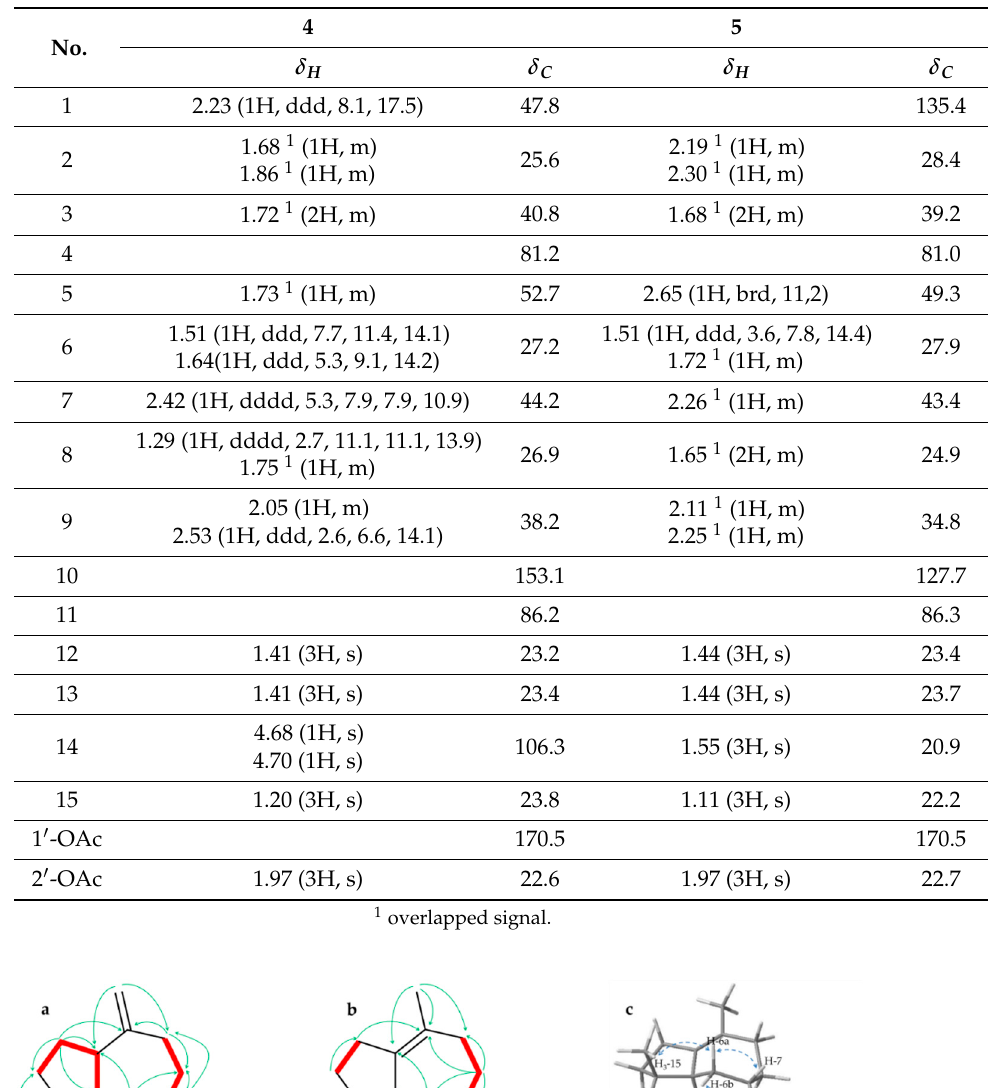
Table 2. 1 H and 13 C-NMR data (400 and 100 MHz, respectively; CDCl 3 , δ in ppm, J in Hz) for compounds 4 and 5 (s singlet, d doublet, br broad, m multiplet).